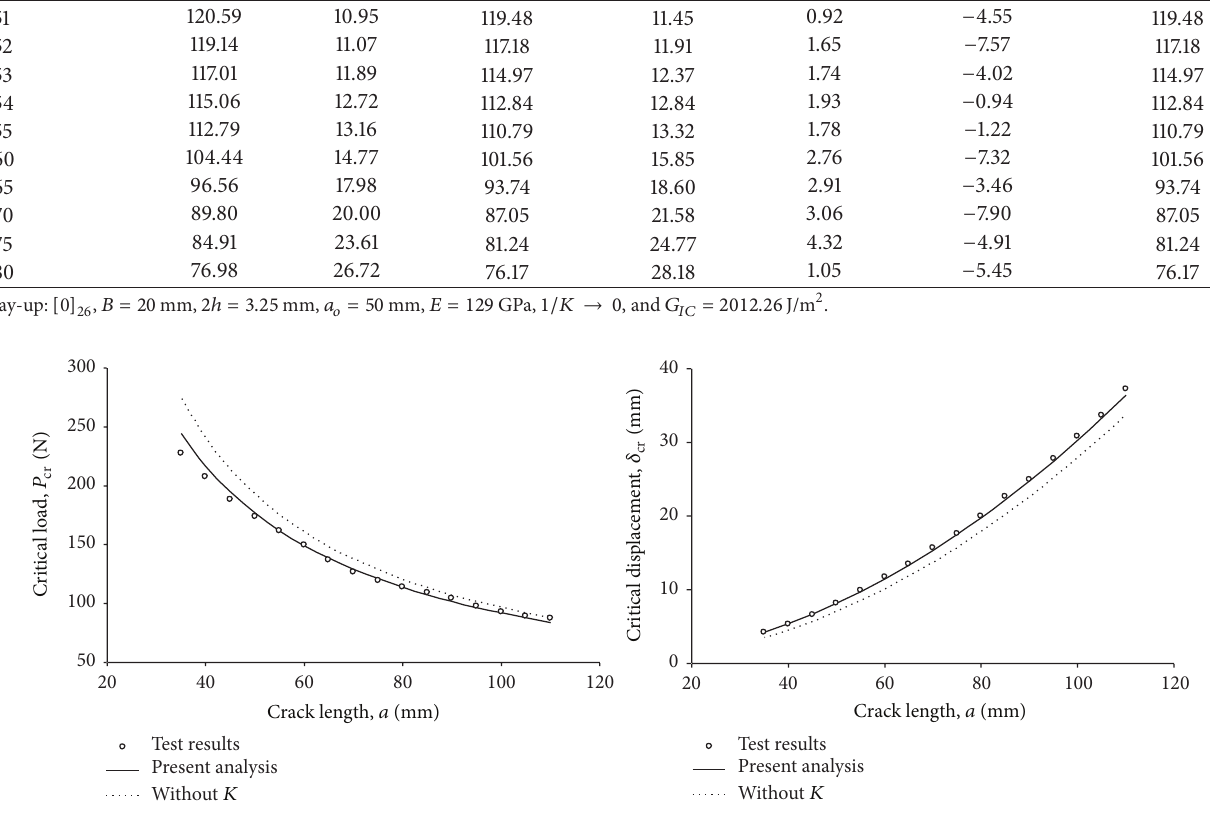
Figure 4: Comparison of experimental [8] and fracture analysis results of the critical load (𝑃 the crack length of unidirectional DCB specimens made of carbon/PEEK composites ( 𝐵 = 20 mm, 2 ℎ = 4.4 mm, 𝐸 = 130 GPa, 𝐾 = 500 Nm, and 𝐺 𝐼𝐶 = 2006 J/m 2 ).